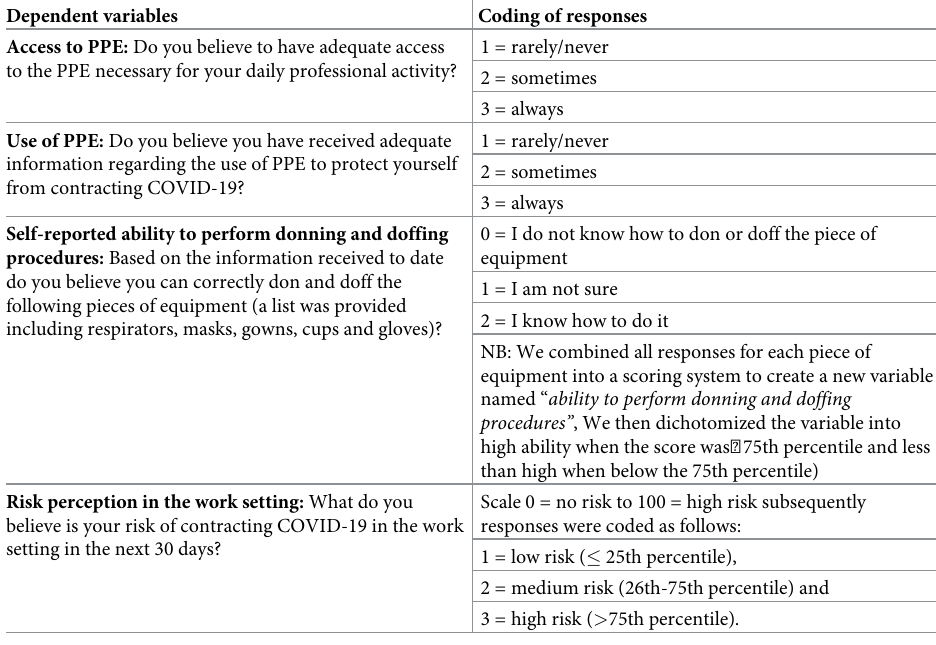
Table 1. Dependent variables: Survey questions and